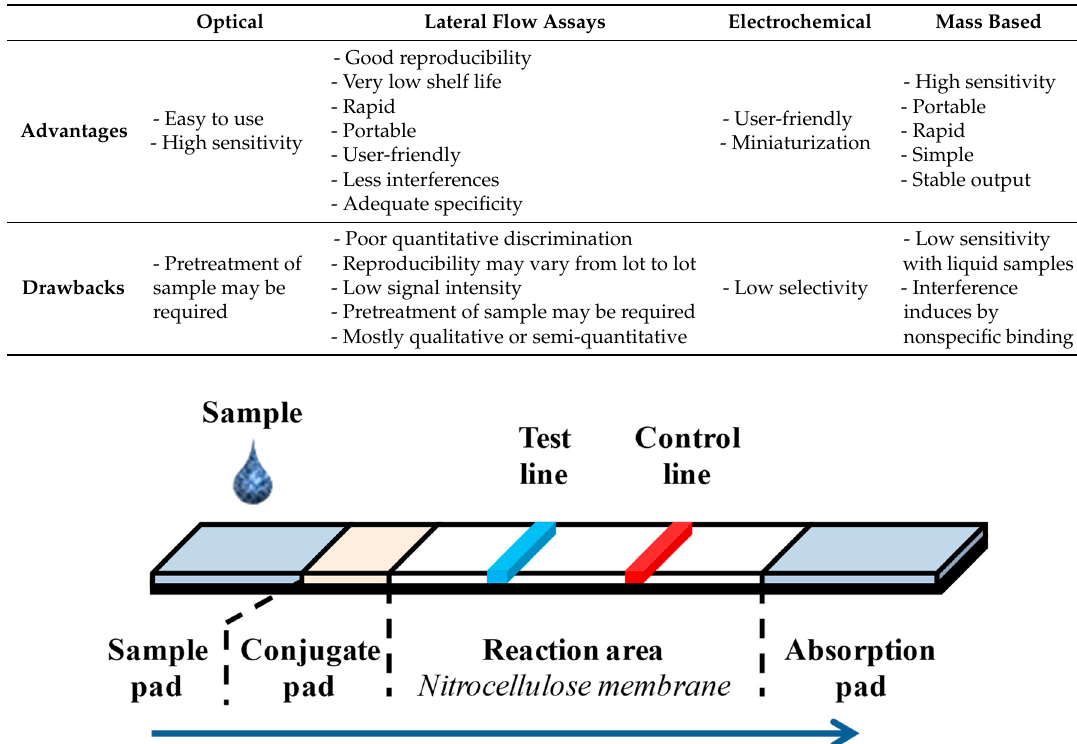
Table 3. Advantages and drawbacks of the biosensors and aptasensors technologies used for the detection of Salmonella in food.